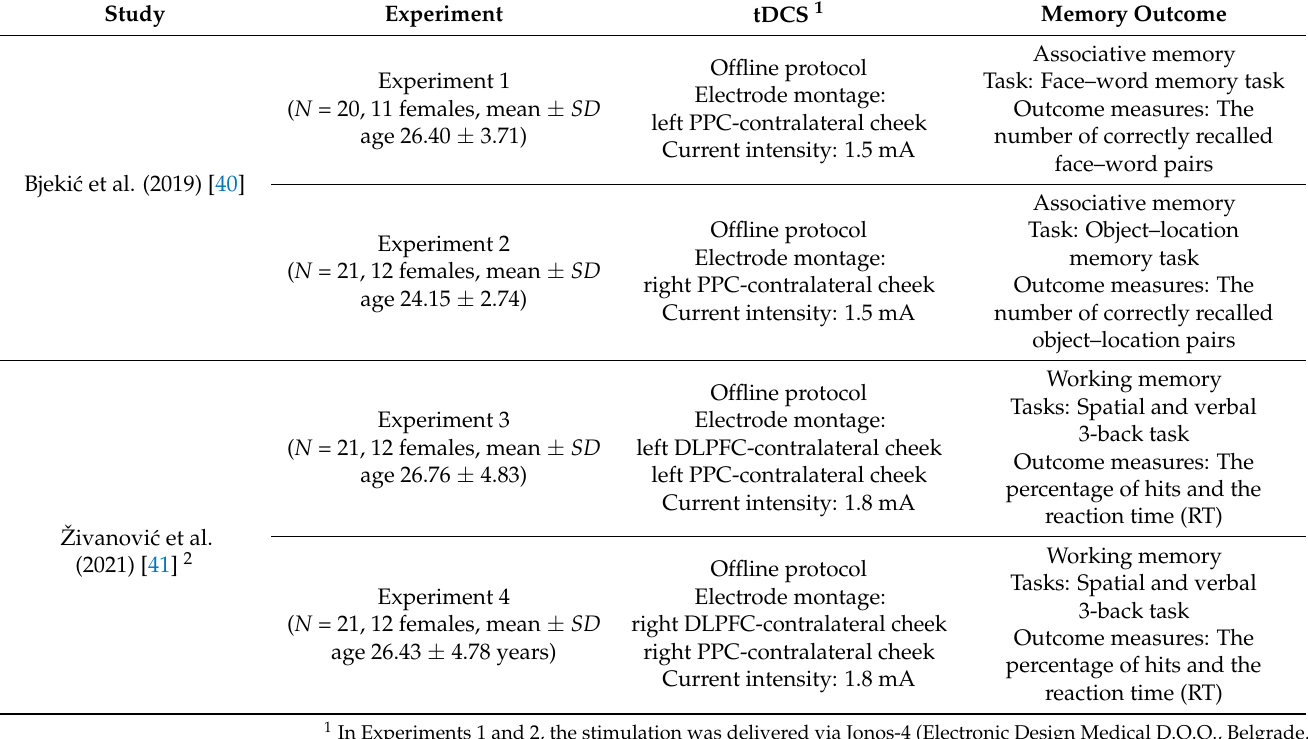
Table 1. Main methods’ characteristics of the Experiments